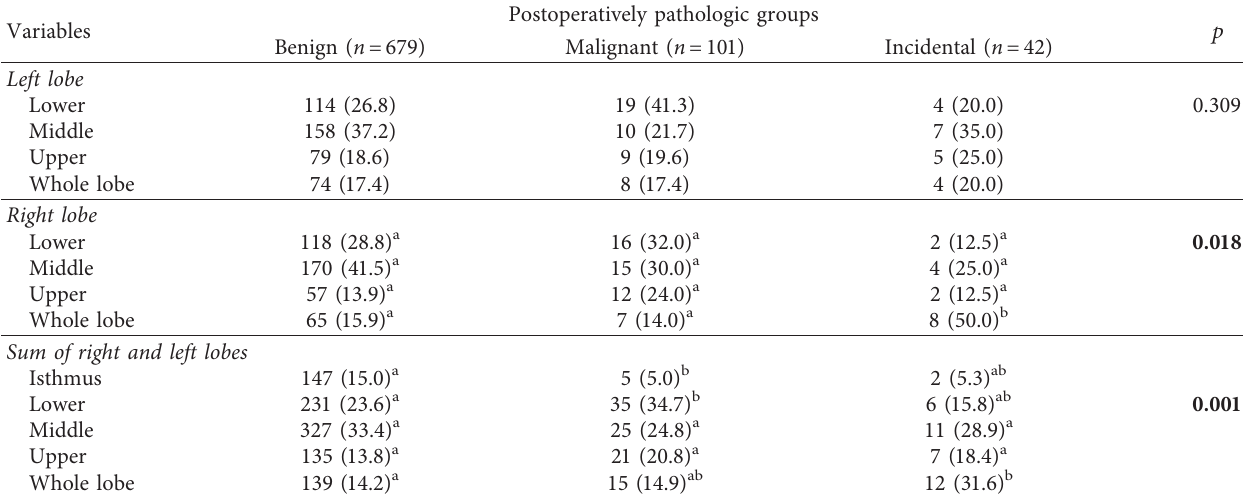
Table 6: Nodule localization relationship with postoperatively pathologic